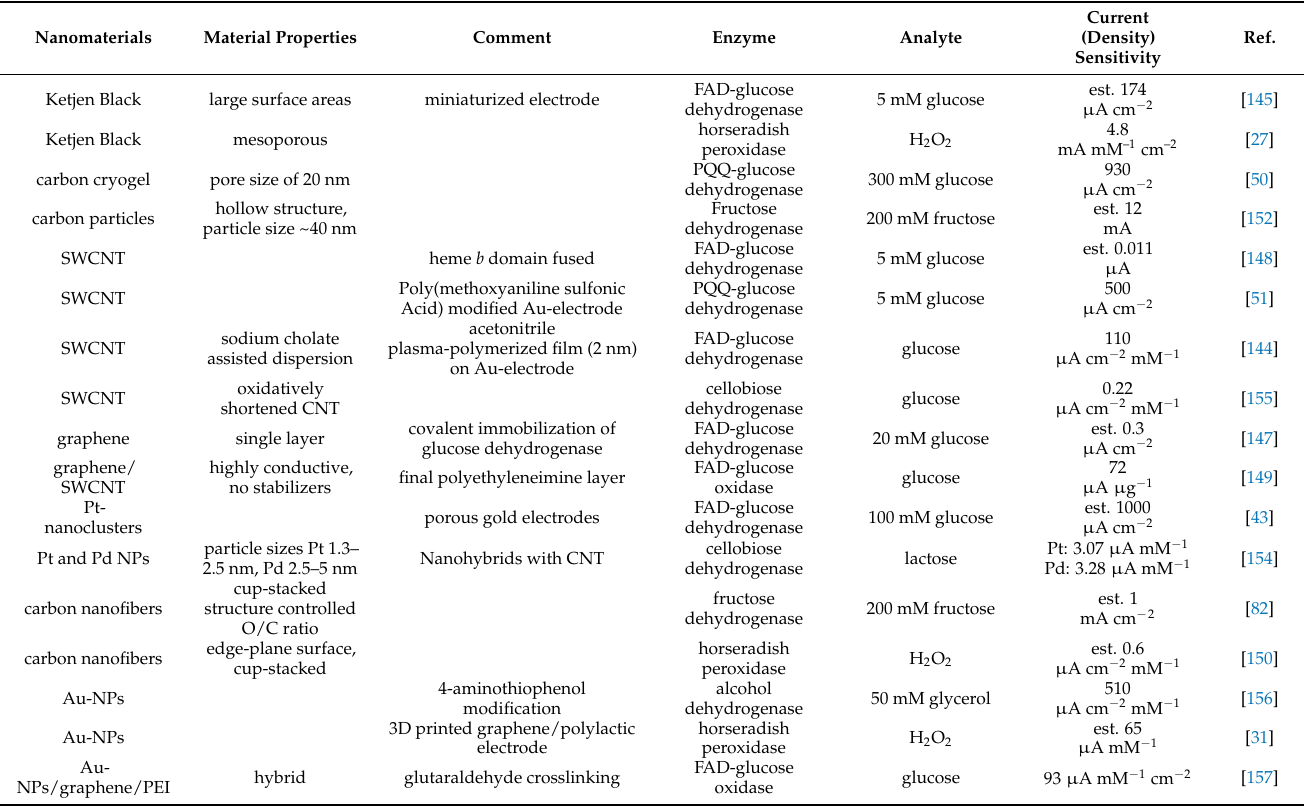
Table 3. Nanomaterials, modifications, and performance of DET